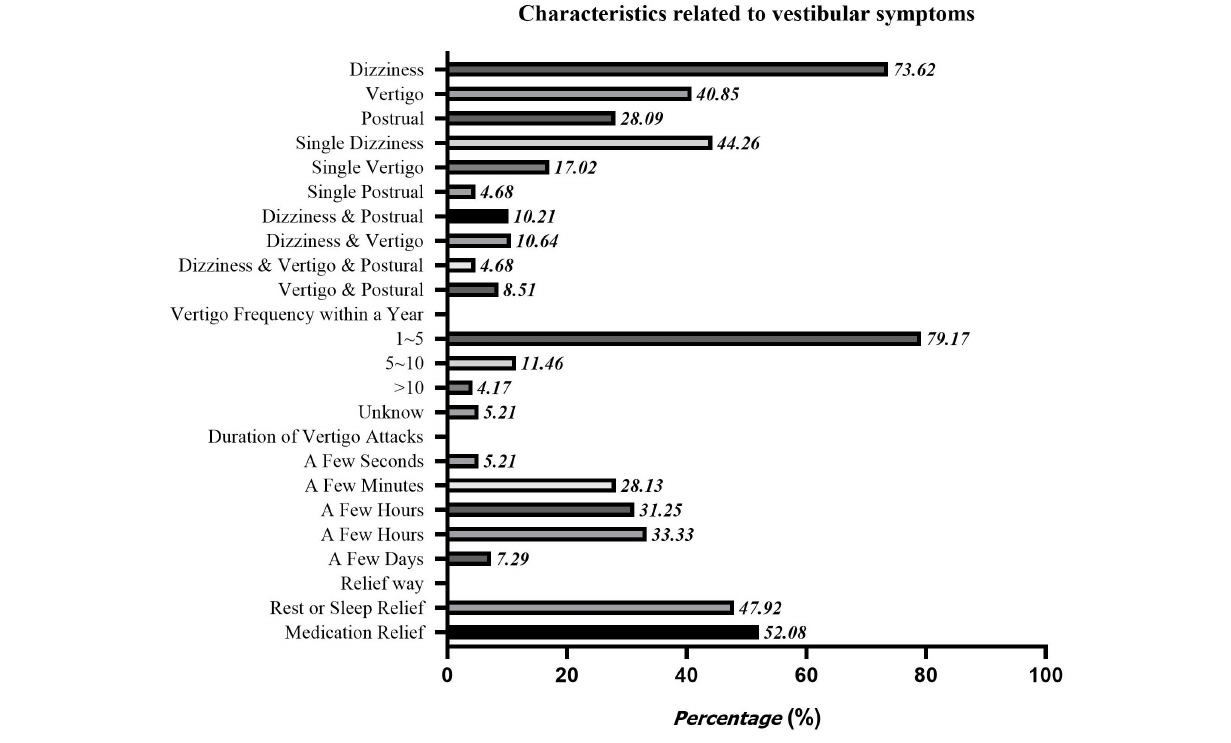
FIGURE 3 | Characteristics related to vestibular